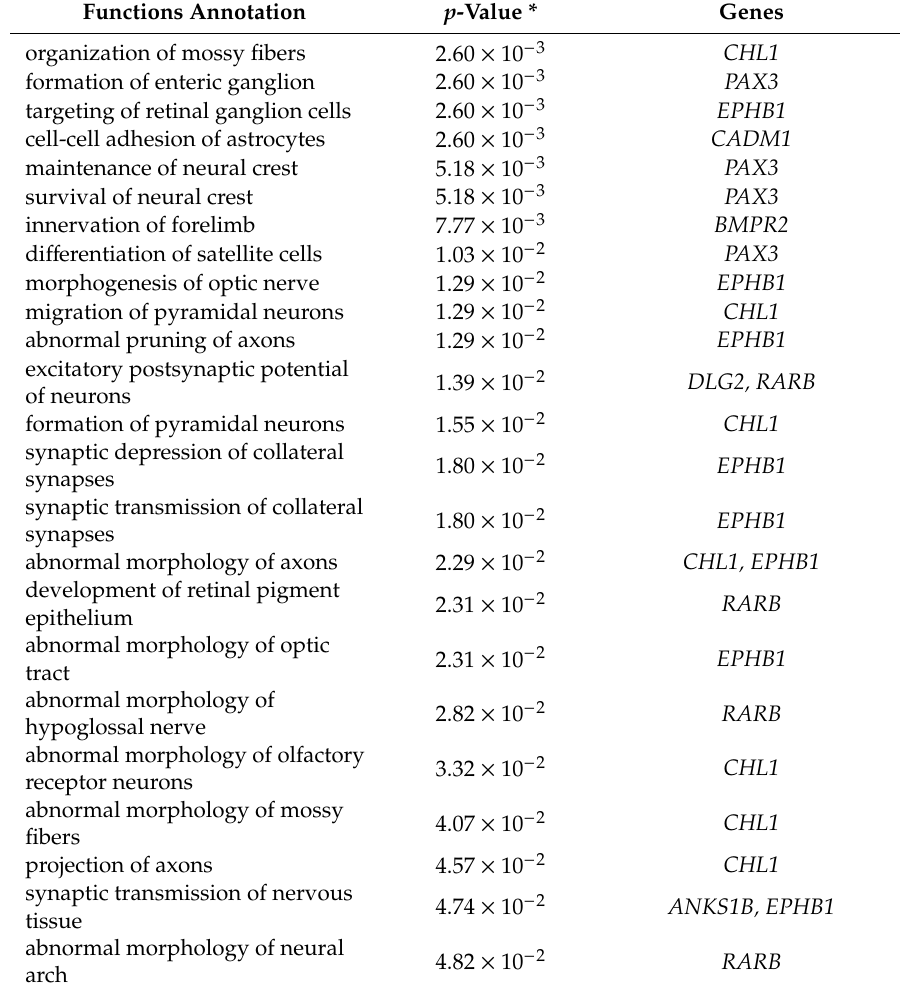
Table 5. Neurological functions associated with genes implicated by nonverbal QTNs.